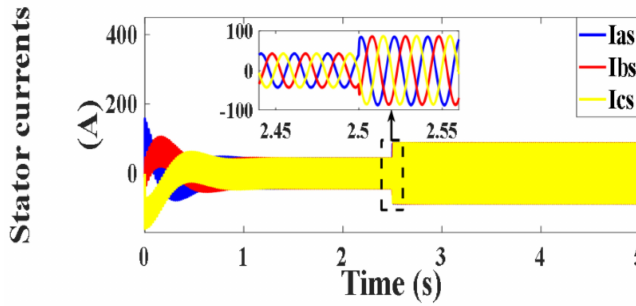
Figure 21. Stator currents under SVOC (A).